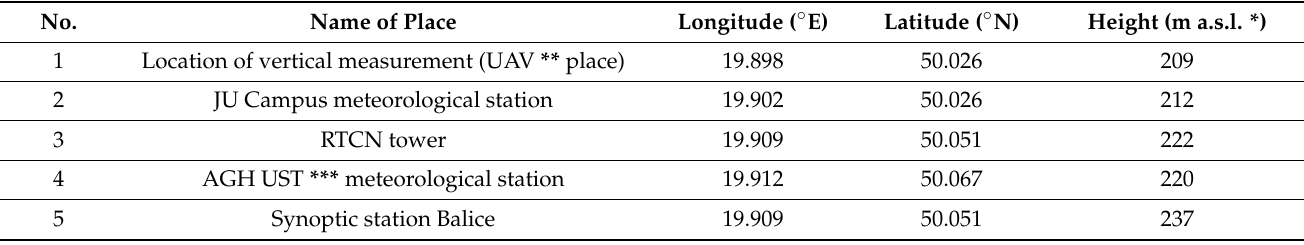
Table 3. Geographical coordinates of measurement points.